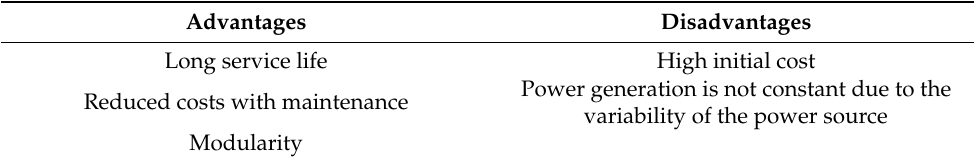
Table 5. Advantages and disadvantages of photovoltaic solar